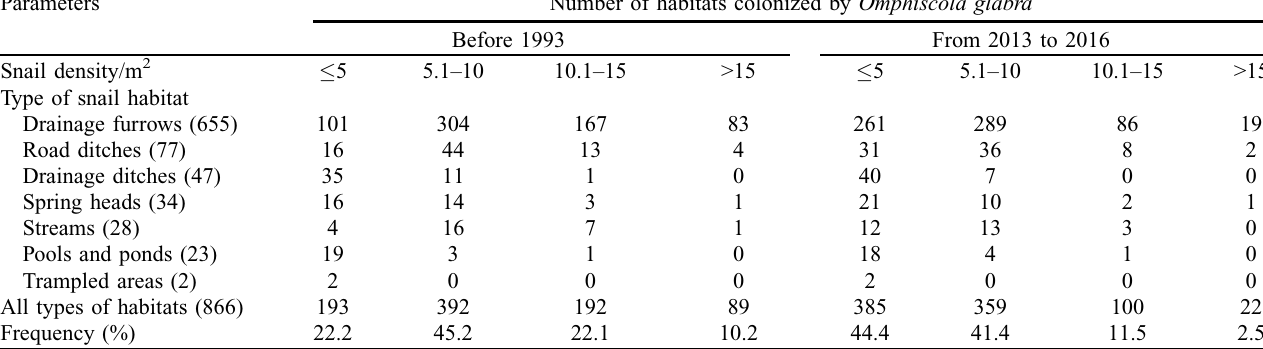
Table 6. Distribution of 866 habitats colonized by Omphiscola glabra on the 162 farms before 1993 and in 2013–2016 in relation to the type of habitat and the number of overwintering snails counted in March or April. The total number of snail habitats is given after each type of habitat (first column).